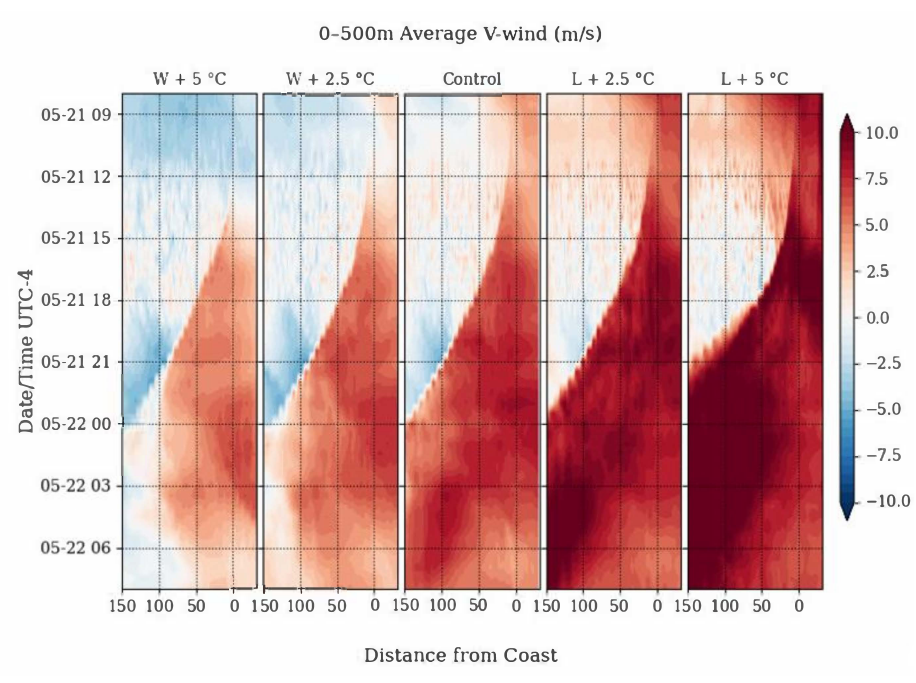
Figure 9. Average meridional wind over the lowest 500 m above the ground as a time series over a 24-h period from 21 May 2019 to 22 May 2019. SRS is located 150 km from the coast (left axis). The control simulation shows higher dew points over the ocean and the coastal region, with a genesis of the sea breeze at around 14 local time, with a clear sea breeze front advancing from the coast towards the inland regions. The front arrives at 0 local time in the Control simulation. The dew point shift is accompanied by a shift to southerly across-shore winds that carry the front